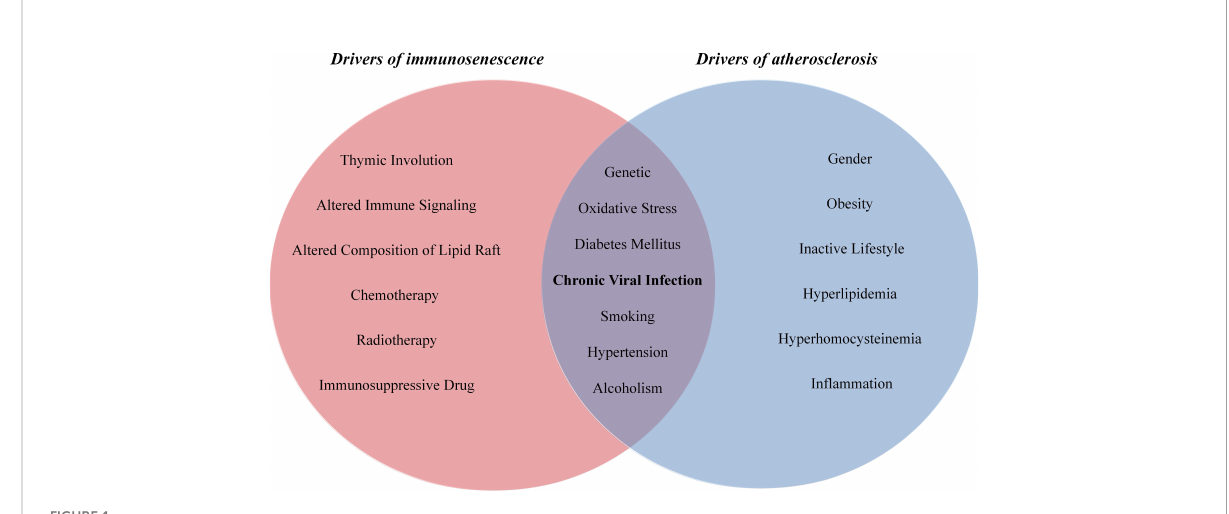
FIGURE 1 The drivers of immunosenescence and